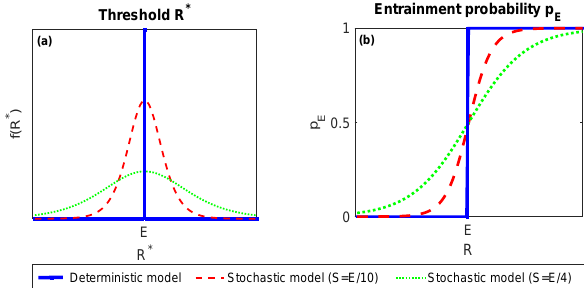
Figure 2. Deterministic and stochastic parameterization of entrain- ment in CAST. (a) The probability density function of the threshold R ∗ . (b) Entrainment probability as a function of relative exposure R